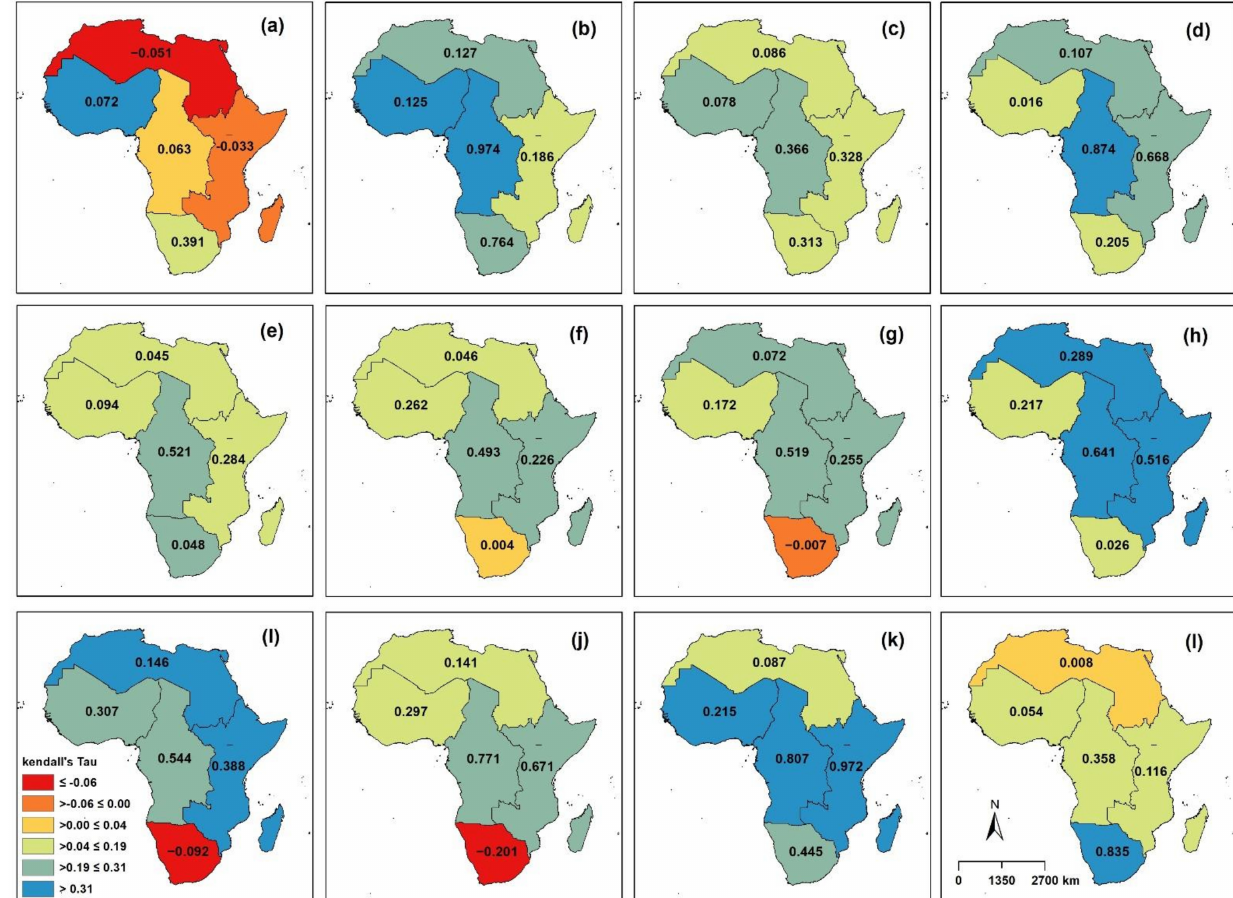
Figure 8. Kendall’s Tau (colour gradient) and Sen’s slope (numbers) for monthly rainfall trends for five African regions between 1983 and 2020. ( a ) January, ( b ) February, ( c ) March, ( d ) April, ( e ) May, ( f ) June, ( g ) July, ( h ) August, ( i ) September, ( j ) October, ( k ) November and ( l )